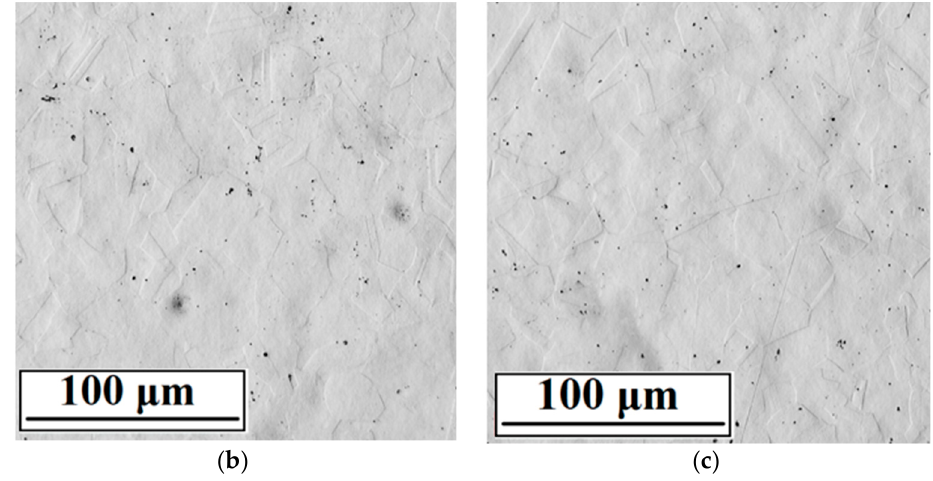
Figure 2. DOM surface morphology micrographs of surfaces ( a ) as received, ( b ) PEP, ( c ) PPEP (QBQ, magnification 600×).